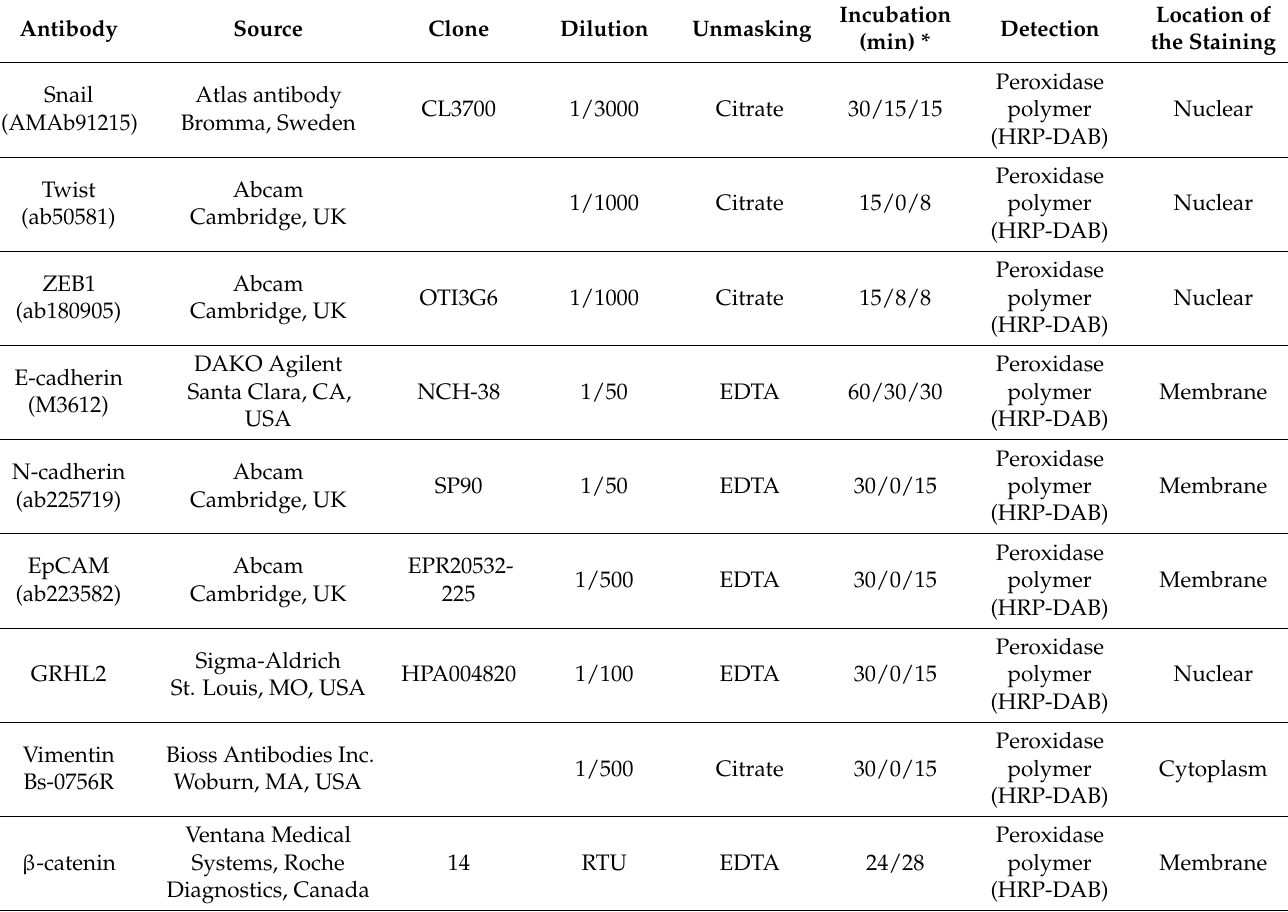
Table 1. List of antibodies used in the immunohistochemical